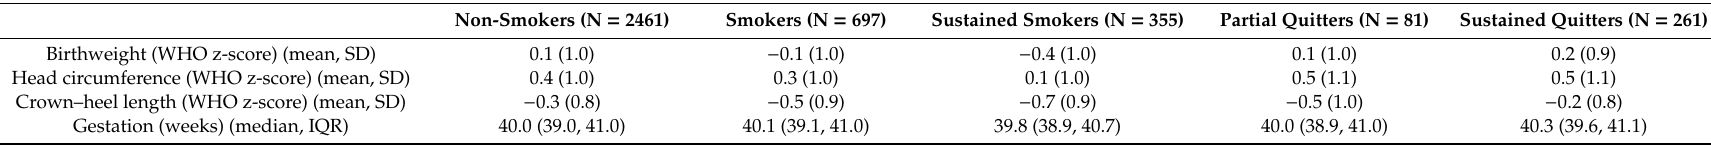
Table 3. Infant characteristics according to maternal smoking status. Results expressed as mean (standard deviation), median (interquartile range) as appropriate.